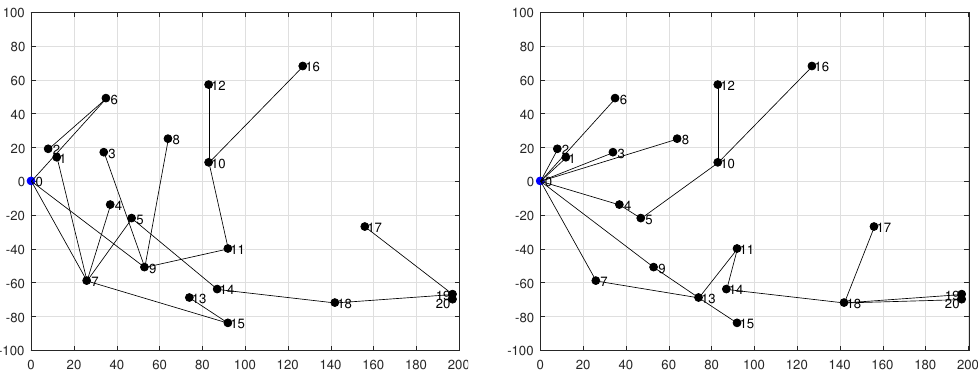
Figure 12. 20-node topologies after simulation with DC = 3% ( left ) and DC = 10% ( right